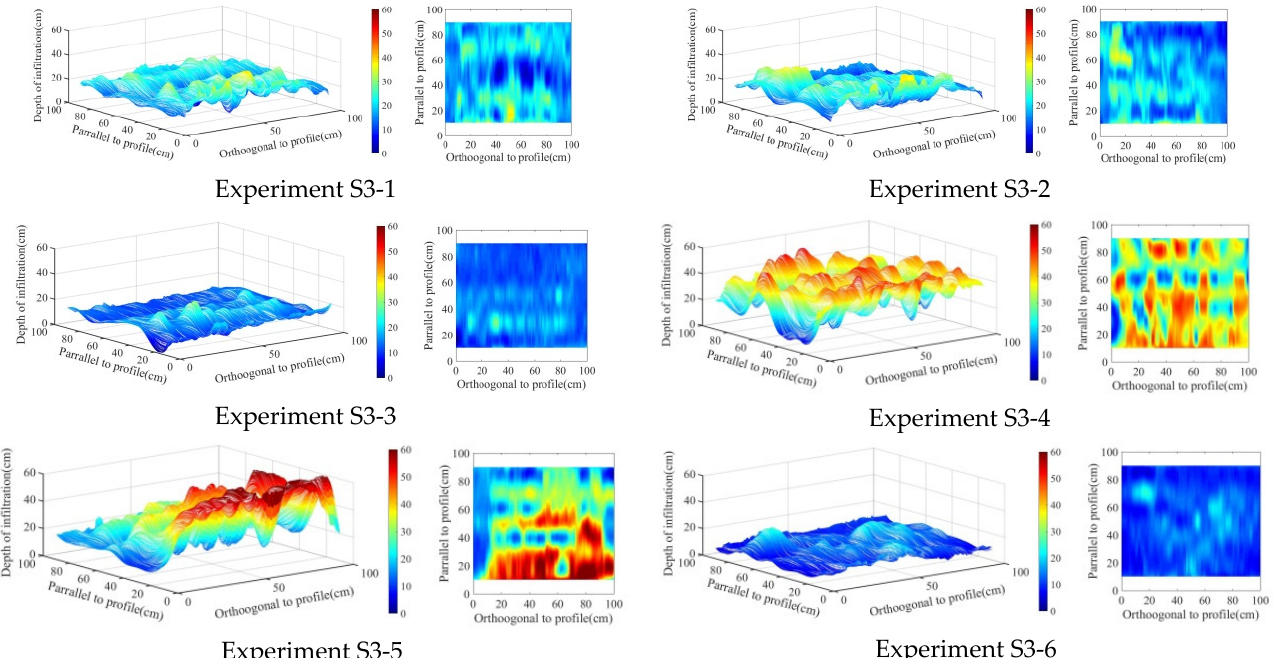
Figure 6. Spatial distribution of infiltration depth under experiment S2.